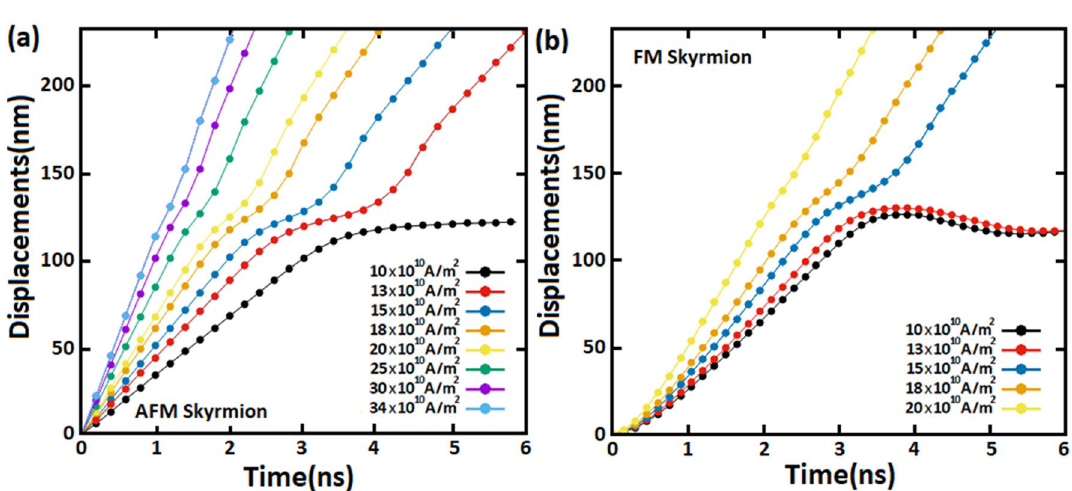
Figure 4. Displacements of ( a ) AFM and ( b ) FM skyrmions by various spin-polarized currents (SOTs) along racetrack memories with a notch size of R n